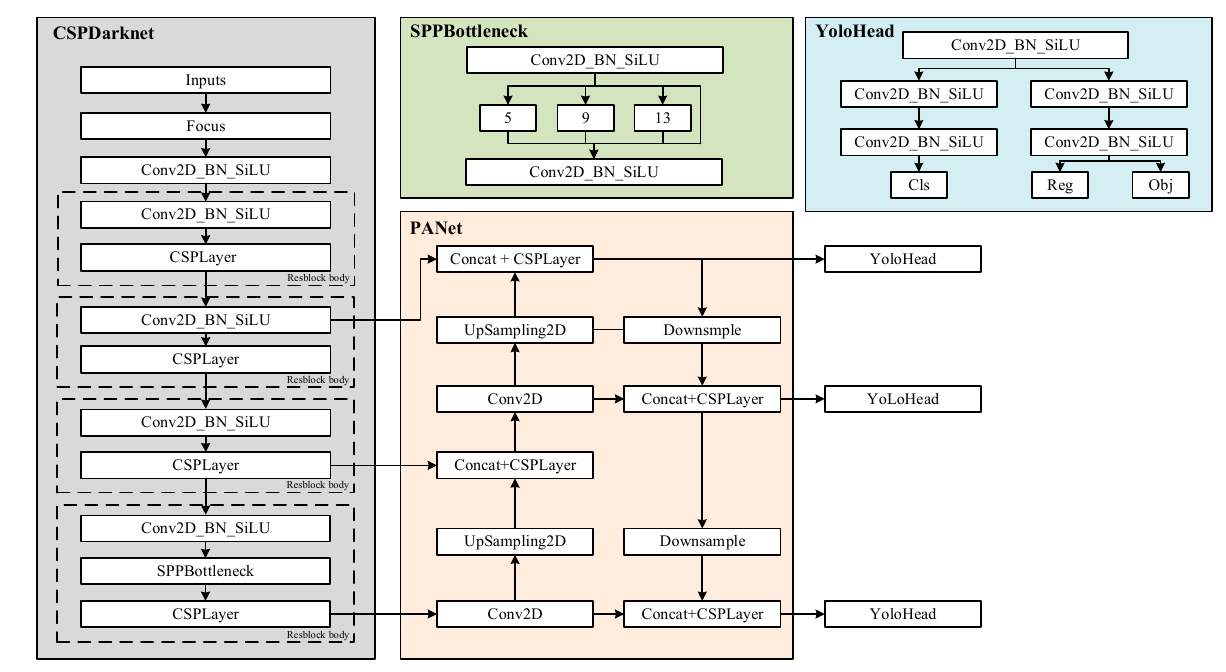
Figure 1. The architecture of YOLOX.